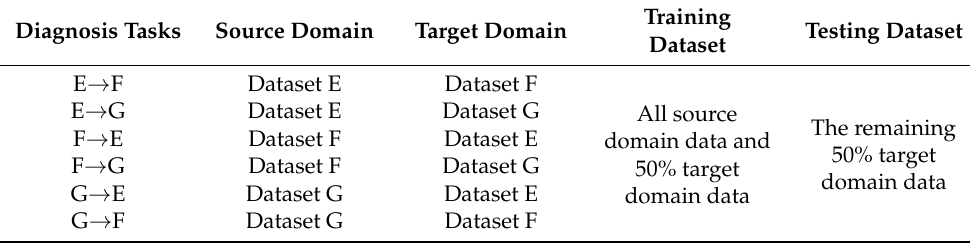
Table 6. Transfer diagnosis experiment in the diagnosis case 2.